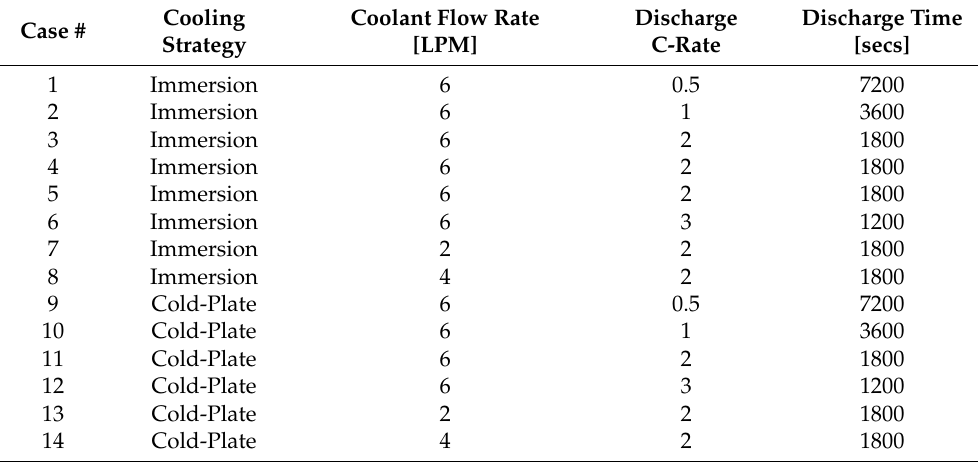
Table 4. Simulation matrix with coolant flow rate and battery module discharge